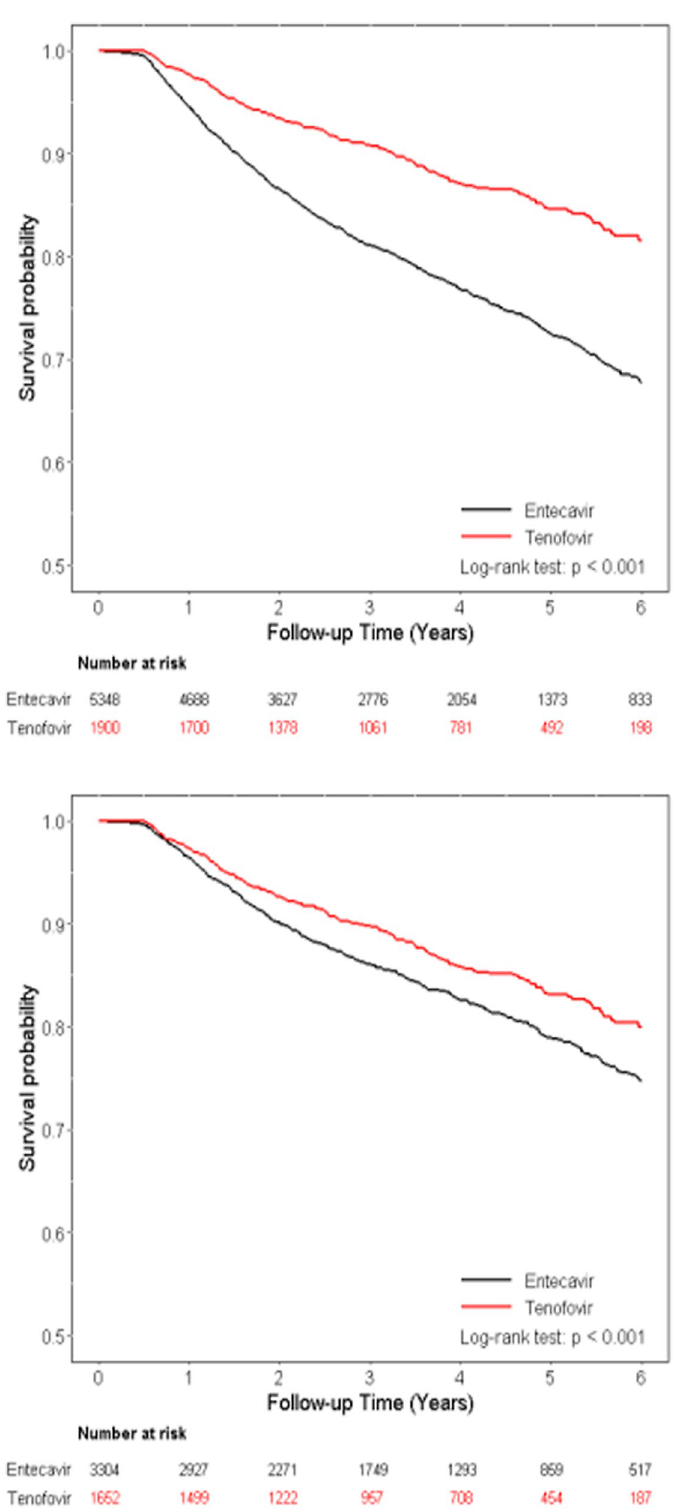
Figure 3. Cumulative incidences of overall survival. ( A ) Entire cohort ( B ) Propensity score matching